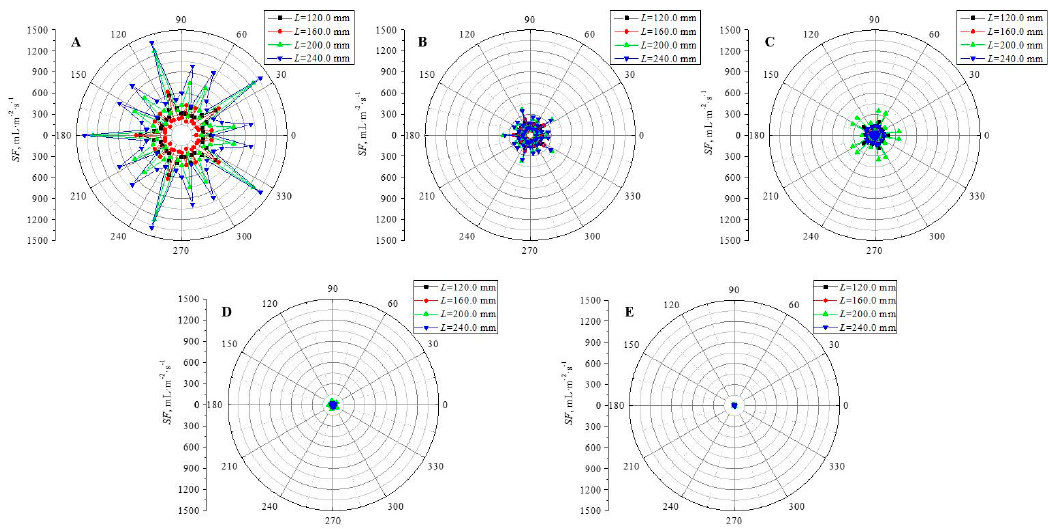
Figure 6. SF on the furnace inner wall at the height of 192.0 mm ( A ), 288.0 mm ( B ), 384.0 mm ( C ), 480.0 mm ( D ), and 606.0 mm ( E ) above bath surface ( Q = 36.4 Nm 3 ·h − 1 ).